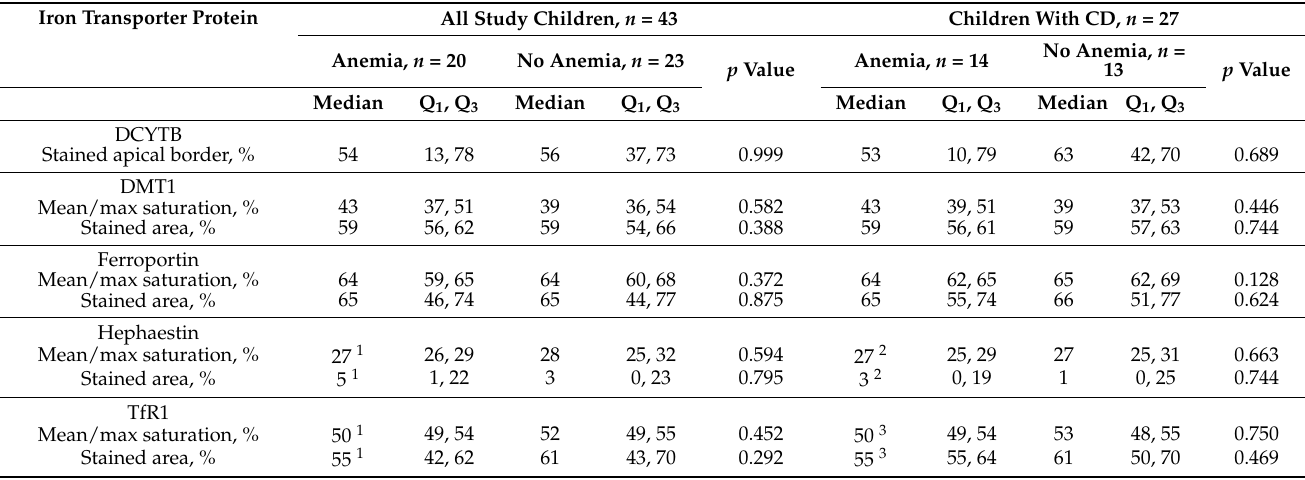
Table 3. Iron transporter protein saturations and the stained areas of enterocytes in the duodenal biopsies of children with and without